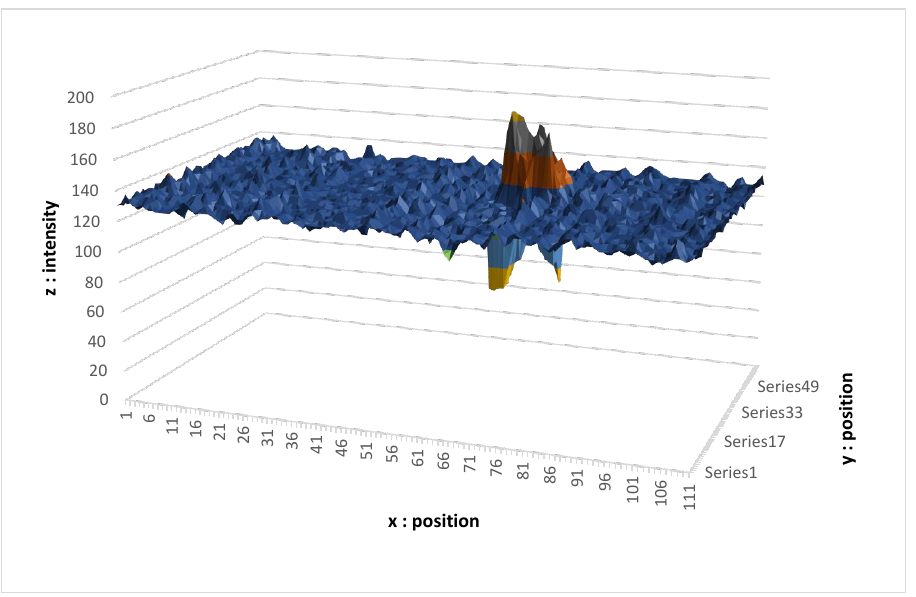
Figure 10. Signal obtained in very high luminosity.